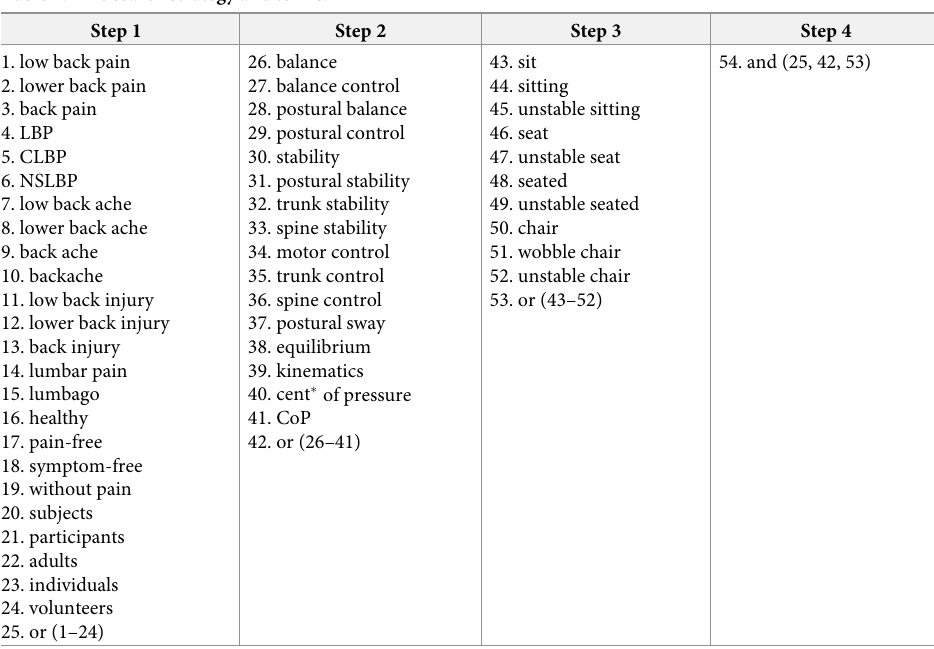
Table 1. The search strategy and